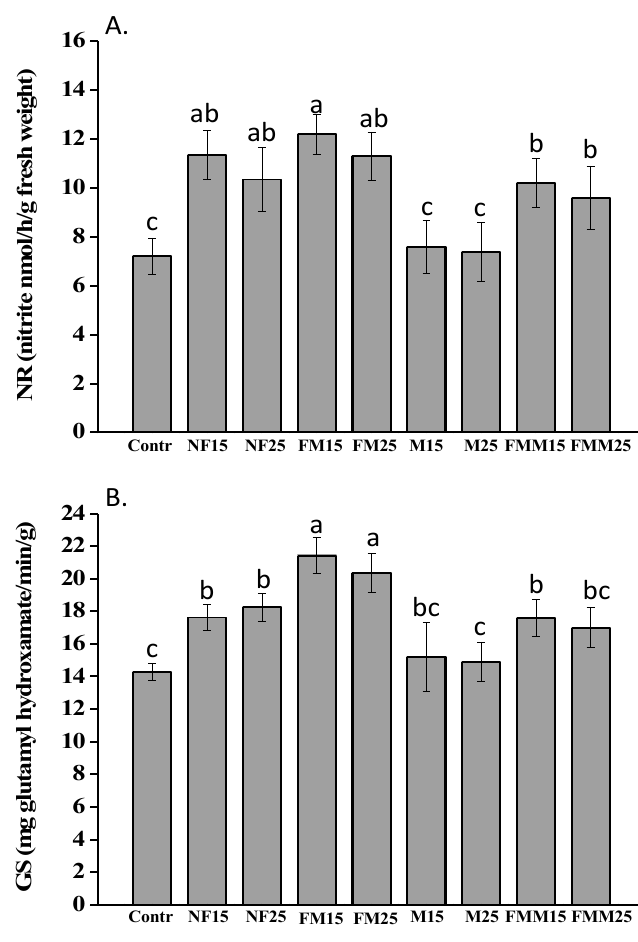
Figure 6. E ff ect of HS extracted from earthworm coprolites collected in soils fertilized with no inputs (NF), or with manure (FM), mineral fertilizers (M) and with manure plus mineral fertilizers (FMM), on the activity of ( A ) nitrate reductase (NR) and ( B ) glutamine synthase (GS) enzymes. HS were supplied for two days at two dosages, either 15 mg C/L or 25 mg C/L, to oat plants grown for 12 days in a Hoagland modified nutrient solution. Control plants (contr) were not added with HS. Data represent the means of three measurements with five plants in each (SD). Different letters above bars indicate significant differences between treatments at p < 0.05 according to Student–Newman–Keuls test.